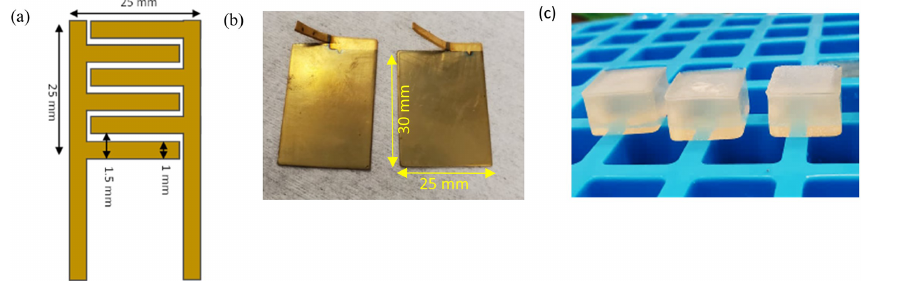
Figure 1. (a) Interdigital electrode for in vitro measurement, (b) metal pads with gold coating for in vivo measurement, (c) picture of the phantom